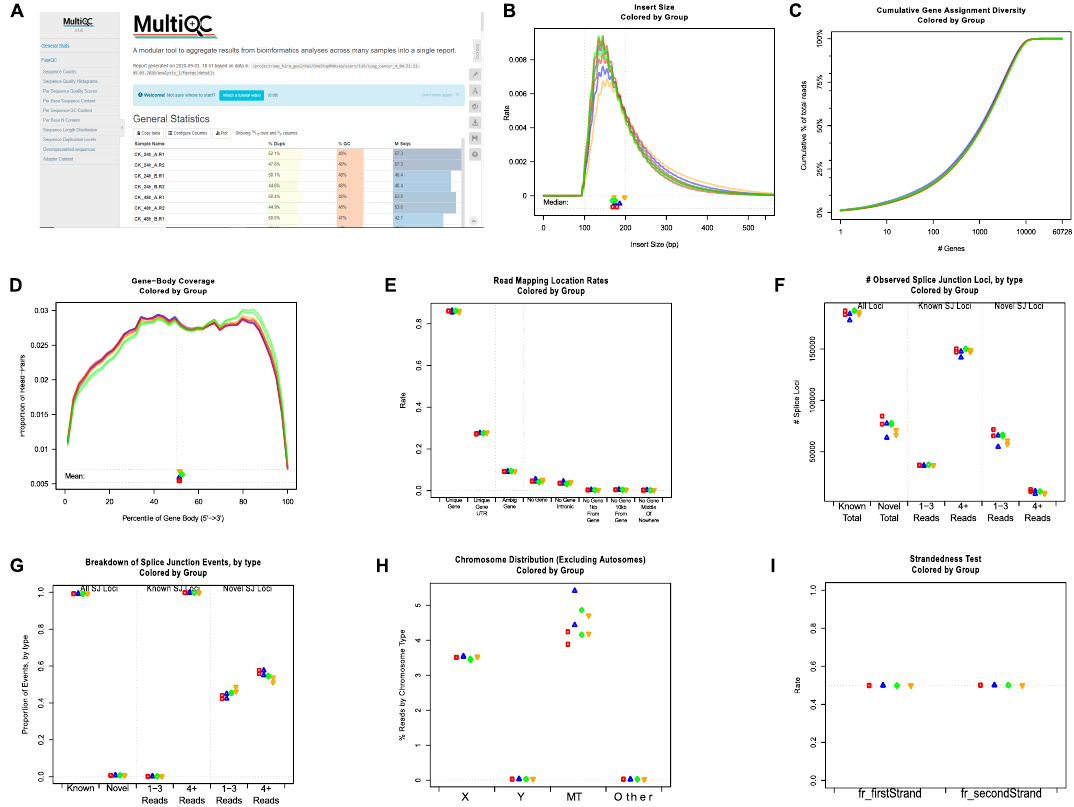
Figure 2. Representative plots showing quality control results generated by FastQC / MultiQC and QoRTs. ( A ) Top part of the HTML report generated using MultiQC by integrating the individual QC report outputted by FastQC. (B-I) Representative post-alignment QC plots generated by QoRTs. ( B ) Distributions of RNA-seq library insert sizes. ( C ) Cumulative gene assignment diversity. ( D ) Read coverage along gene body. ( E ) Percentage of reads mapped to di ff erent genomic regions. ( F ) Numbers of known and novel splicing junctions. ( G ) Percentages of known and novel splicing junctions. ( H ) Percentages of reads mapped to non-autosomes. ( I ) Strandedness of RNA-seq